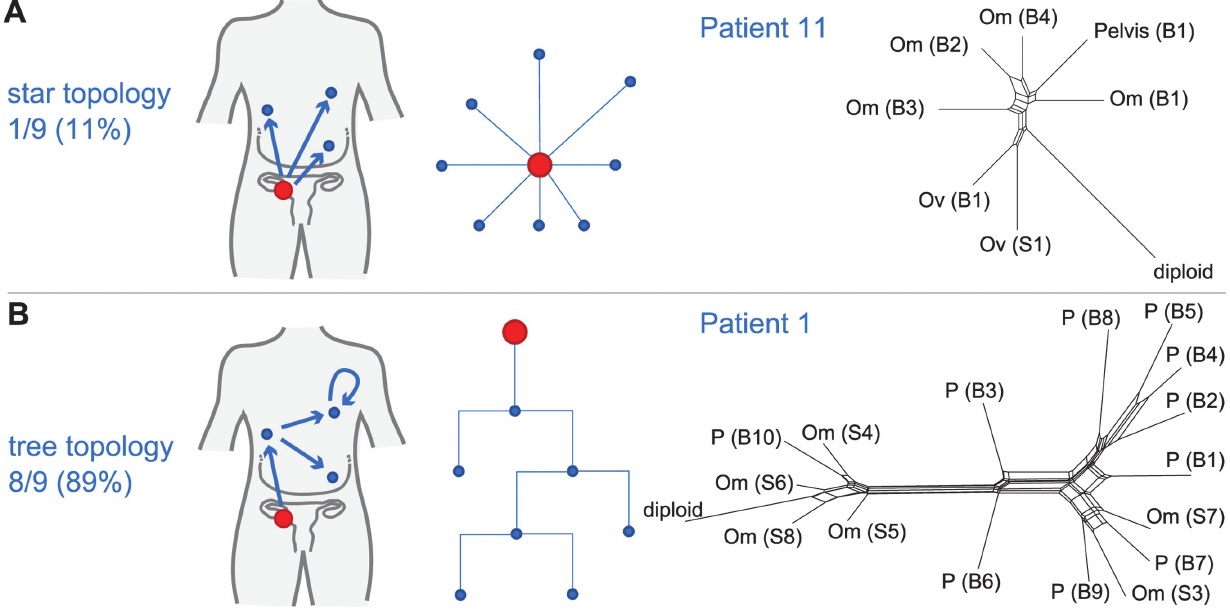
Fig 3. Branching patterns in HGSOC. (A) Radial pattern of metastatic spread leads to a star topology. The schematic shows how the evolutionary relationships are predicted to have a star-like topology if all metastases (blue) are derived from the primary lesion (red). A neighbour-net representation of the evolutionary distances from patient 11 shows deviation from a tree structure (right). (B) Branched metastatic spread leads to a tree topology. The schematic shows that evolutionary history is predicted to be tree-like if metastases create new metastases (including metastasis-to-metastasis spread). A neighbour- net representation of the distance matrix for patient 1 shows a tree-like structure (right). The number and proportion of patients classified to star or tree topology are shown. Labels on trees indicate site of metastasis (Om, omentum; Ov, ovary; P, peritoneum). Sample identifiers indicate whether the sample was collected from pre-chemotherapy biopsy (B) or interval debulking surgery